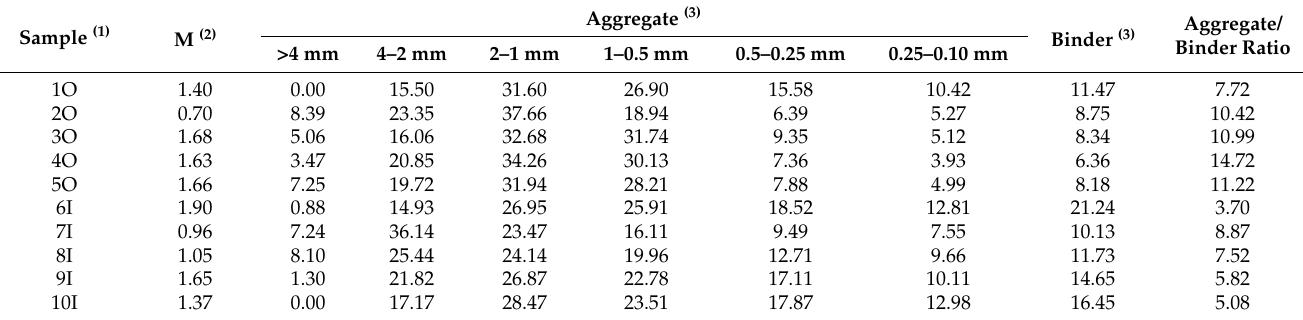
(1) O: from the outer face of the wall. I: from the inner face of the wall. (2) M: moisture content (in percentage). (3)